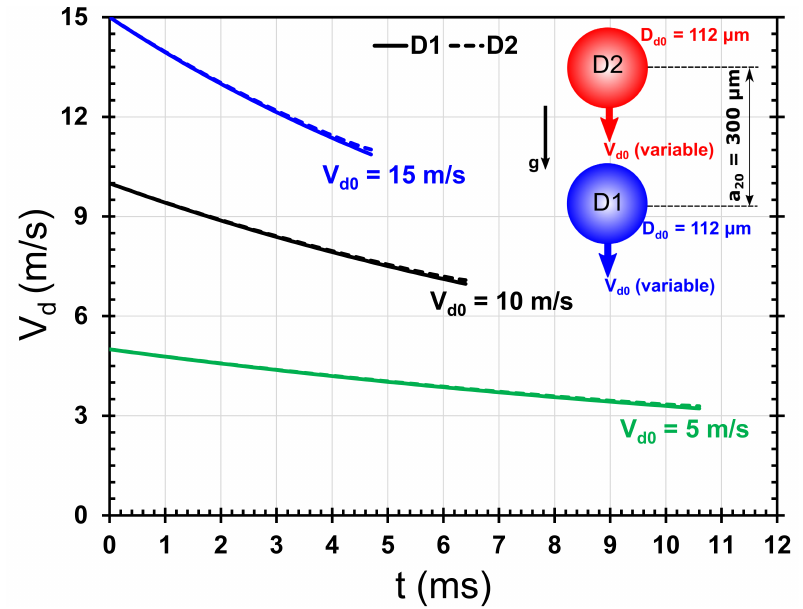
Figure 8. Effect of V d 0 on V d ( t ) : Time evolution of the velocities of leading (D1) and trailing (D2) iso-propanol droplets for three typical cases of initial droplet velocities, V d 0 = 15, 10, and 5 m/s, as predicted by Equations (11) and (12). Other parameters are kept the same as in Figure 4: D d 0 = 112 µ m; a 20 = 300 µ m; C D is calculated using Equation (10). The initial values of the Reynolds number and the aerodynamic Weber number for the three cases (5, 10, 15) m/s are (37.1, 74.3, 111.4) and (0.15, 0.62, 1.39),